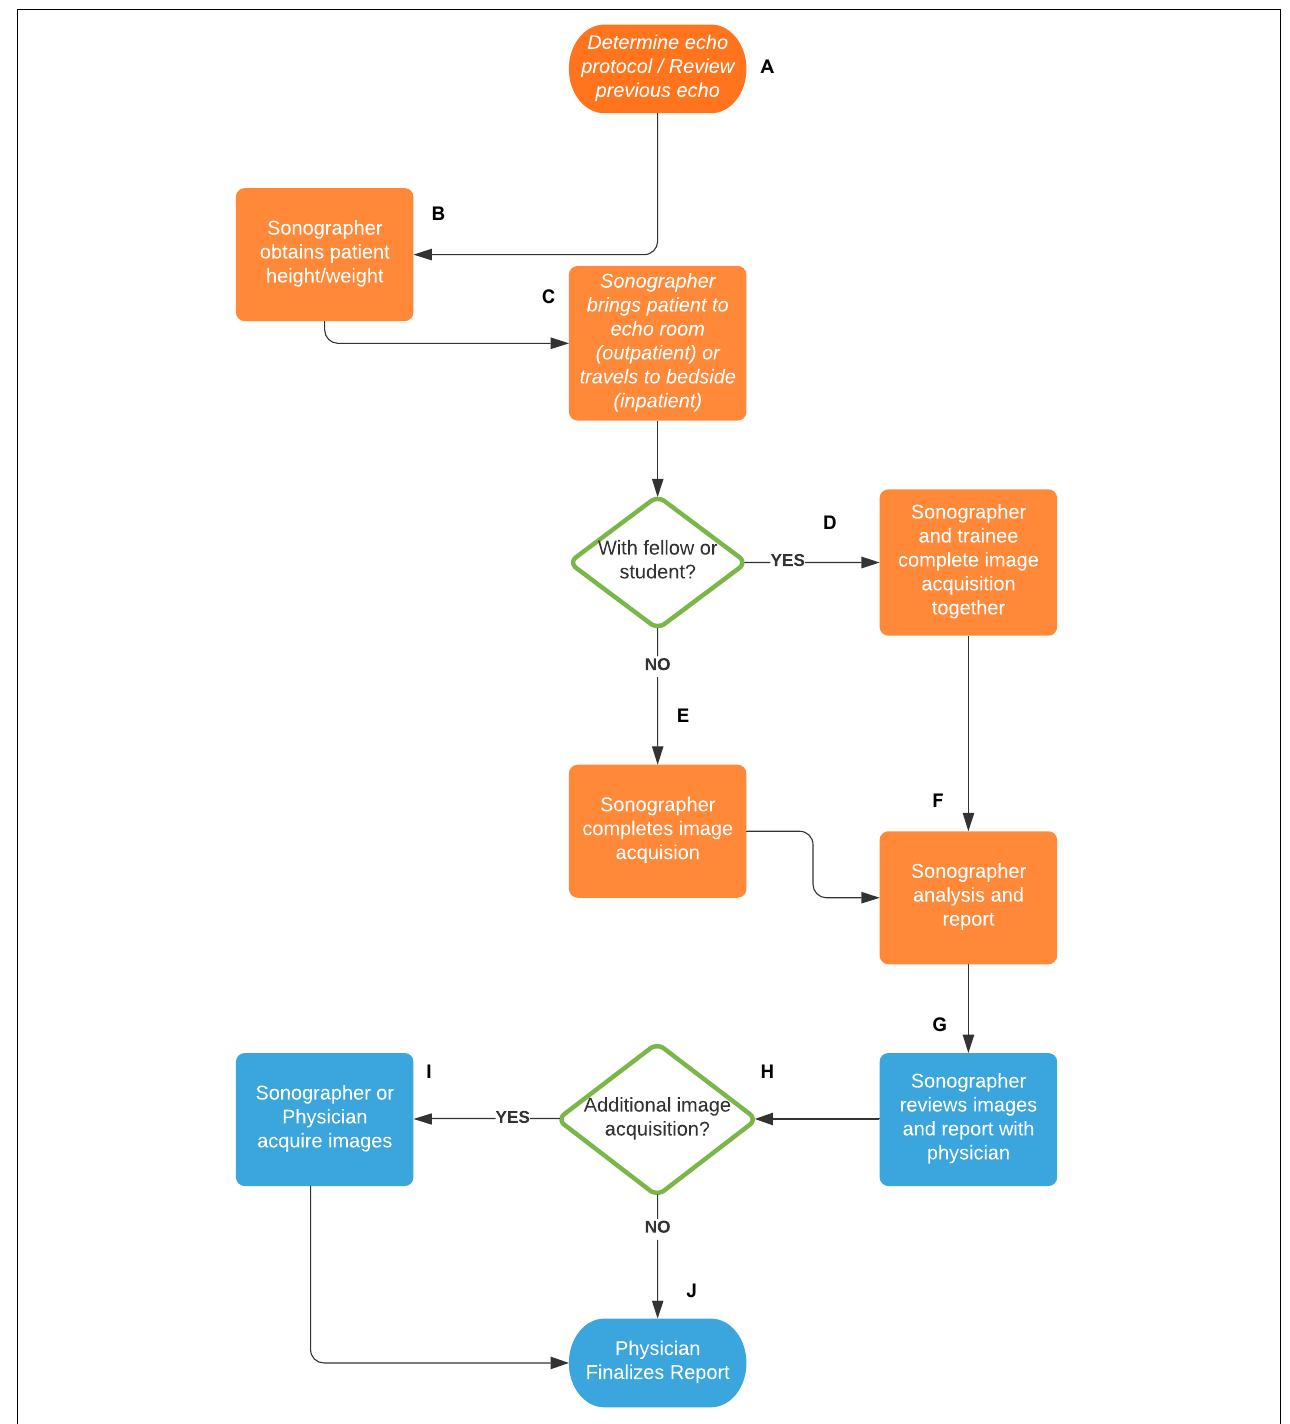
FIGURE 2 | Sonographer-based scanning system at the Hospital for Sick Children of Toronto, Canada. (A) The sonographer reviews the patient echocardiography order and previous echo images to determine the appropriate scanning protocol. (B) The sonographer obtains the patient height and weight for growth and z-score calculations. (C) For an outpatient or mobile inpatient, the sonographer brings the patient into the echo scanning room. For a non-mobile inpatient, the sonographer brings the machine to the patient bedside. (D) If the sonographer is with a trainee (fellow or student), both complete the image acquisition. (E) Without a trainee the sonographer completes the image acquisition alone. (F) After image acquisition, the sonographer reviews them and completes a preliminary echocardiography report, including necessary measurements, findings, conclusions, and diagnostic coding. (G) The sonographer then reviews the images and report with a pediatric cardiologist. (H) The cardiologist determines whether any additional images need to be acquired. (I) If yes, the sonographer or cardiologist will acquire additional images. (J) If no, or following the additional images, the cardiologist finalizes the echocardiography report.